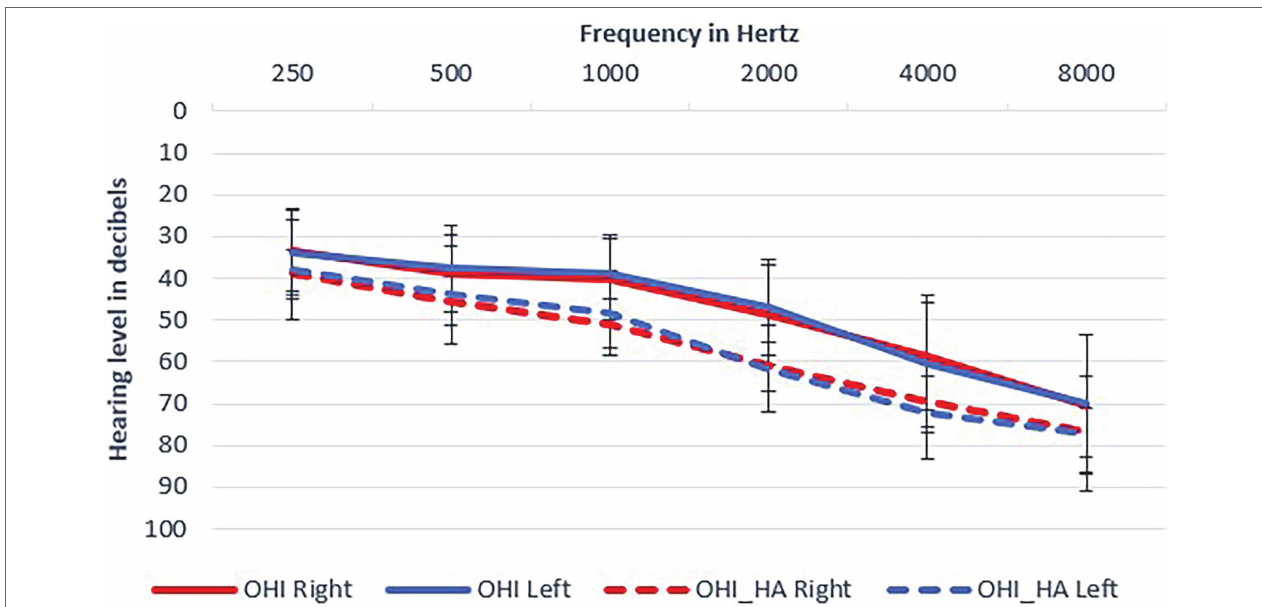
FIGURE 1 | Mean audiograms of participants. Mean thresholds and standard deviations are shown: older hearing-impaired adults (OHI) in full lines; older hearing- impaired adults who use hearing aids (OHI-HA) in dashed lines.